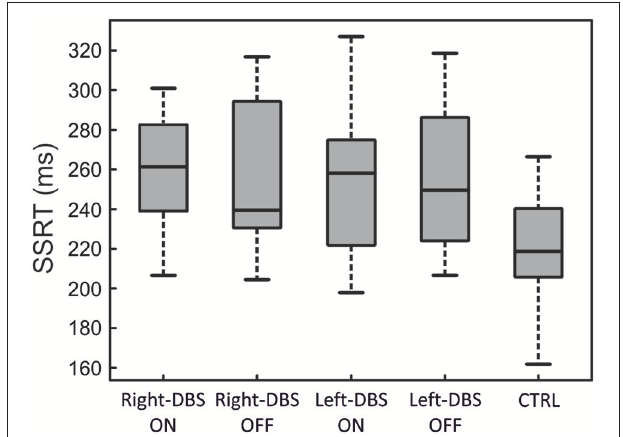
FIGURE 3 | SSRT in right-DBS-ON and -OFF patients ( n = 10), left-DBS-ON and -OFF patients ( n = 10), and age-matched controls ( n = 22). In the box plots, the boundary of the box closest to zero indicates the first quartile, a black thick line within the box marks the median, and the boundary of the box farthest from zero indicates the third quartile. Whiskers indicate values 1.5 times the interquartile range below the first quartile and above the third quartile.